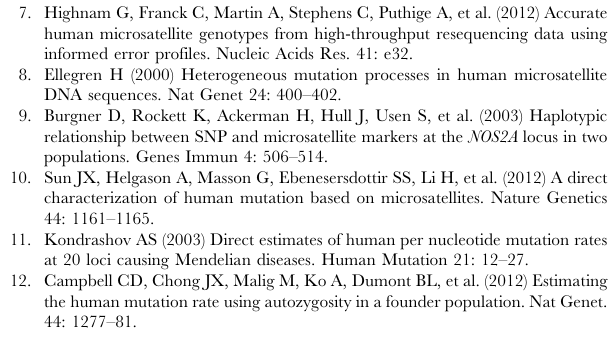
Table S3 Summarized absolute copy numbers of multicopy genes and macrosatellites in 165 HapMap individuals. Abbrevi- ations: INV: Invariant, VAR: Variant. Table S4 Results of linkage disequilibrium analysis between probe counts and all SNPs located within 6 250 kb of each probe position. For each probe we report the SNP identified with the highest R 2 value with probe count within 6 250 kb. Abbreviations: CEU, CEPH Europeans from Utah; YRI, Yoruba from Ibadan Nigeria; CHB, Han Chinese in Beijing, ALL: Includes CEU, YRI, CHB individuals combined. Table S5 Filtered results of linkage disequilibrium analysis between probe counts and SNPs within 6 250 kb of each probe position. This shows similar results to those presented in Table S4, except for each probe we report the SNP identified with the highest R 2 value with probe count within 6 250 kb after removing SNPs that: (i) overlap regions of common copy number variation (CNVs with $ 10% MAF, [52]), (ii) overlap annotated segmental duplications, or (iii) the 51 bp sequence centered on the SNP does not map uniquely within the genome using BLAT. Abbreviations: CEU, CEPH Europeans from Utah; YRI, Yoruba from Ibadan Nigeria; CHB, Han Chinese in Beijing, ALL: Includes CEU, YRI, CHB individuals combined. Table S6 Results of correlation analysis between probe counts and expression level of genes within 6 500 kb of each probe BLAT position. Copy number of eight multicopy genes ( CCR5 , FCGR , GSTM , GSTT2 , KRTAP1-1 , MAFG , MAGEA9 , UGT2B15 ) shows significant correlation (p , 0.01) with their own expression level. Abbreviations: CEU, CEPH Europeans from Utah; YRI, Yoruba from Ibadan Nigeria, All: CEU, YRI and CHB individuals combined; R and R 2 are derived from Pearson correlations. Table S7 Results of correlation analysis between probe counts and methylation level of autosomal CpGs within 6 500 kb of each probe BLAT position. Reported in this table are all pairwise correlations between Nanostring counts and CpG methylation levels ( b -values) with unadjusted p , 0.01 observed in either the CEU + YRI populations combined as a single group, or in any of the two populations separately (autosomal loci only). Abbrevia-